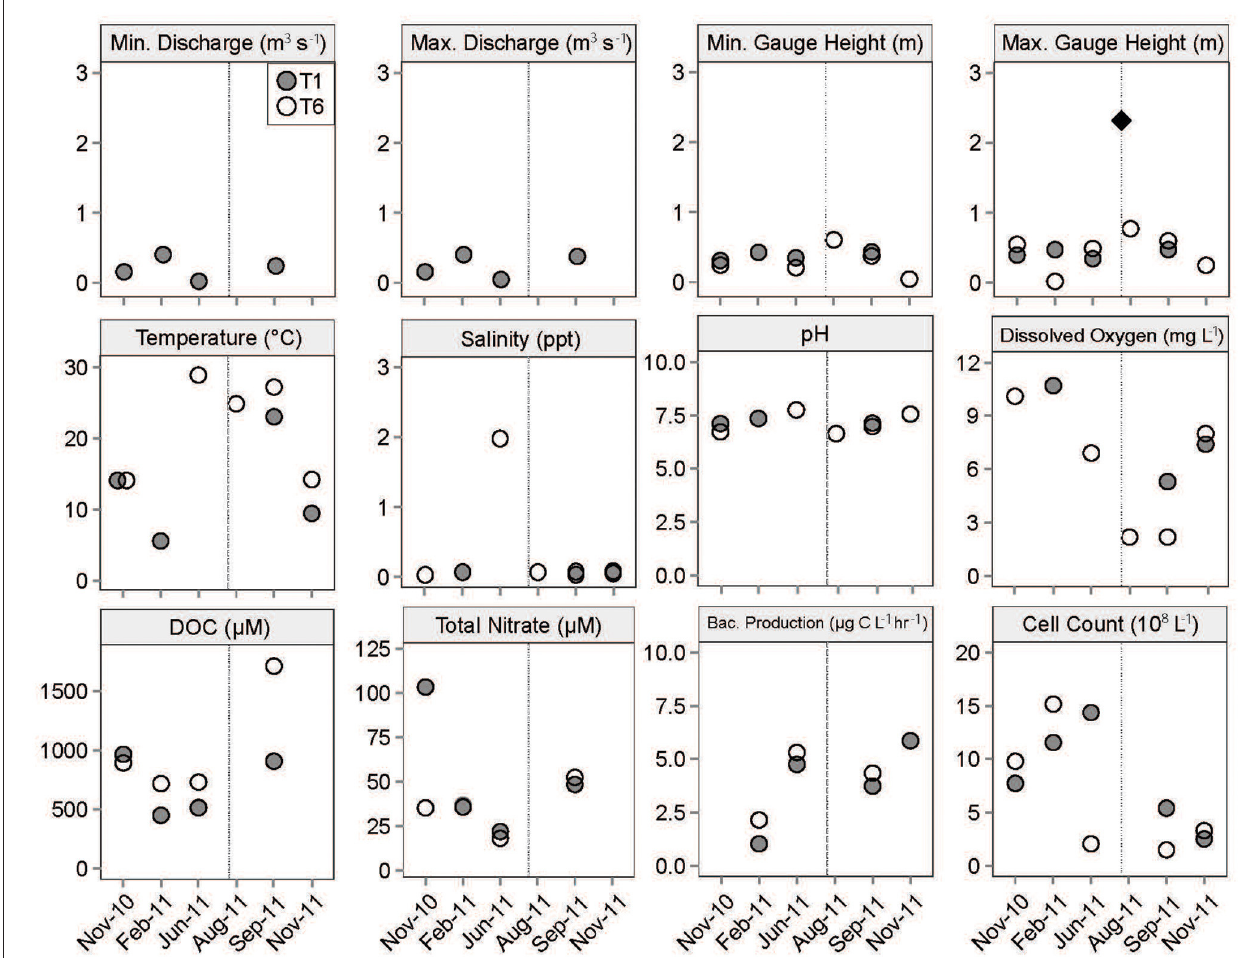
FIGURE 2 | Physical, chemical, and biological parameters from the Tar River at Stn. T1 (upstream) and Stn. T6 (downstream). The diamond in the maximum gauge height plot represents the water level (2.30m, source: USGS) immediately after the landfall of Hurricane Irene (indicated by the vertical dashed line) on August 27, 2011. DOC, cell counts, and bacterial production data are from a separate study ( Bullock,